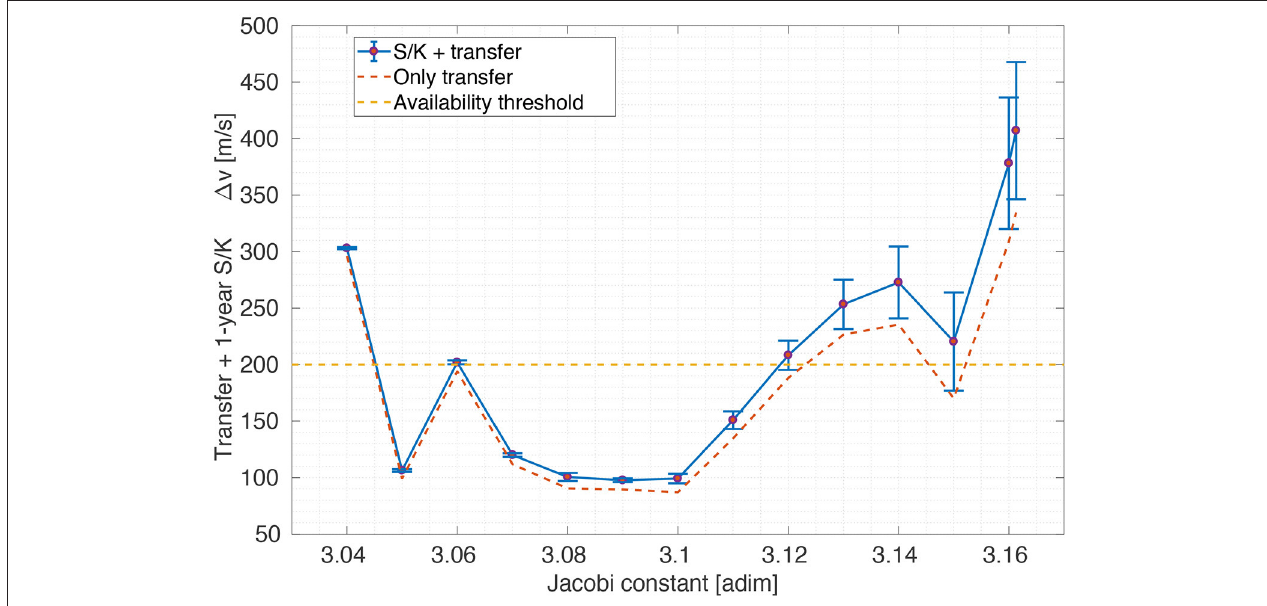
FIGURE 10 | Total transfer cost for different halos.